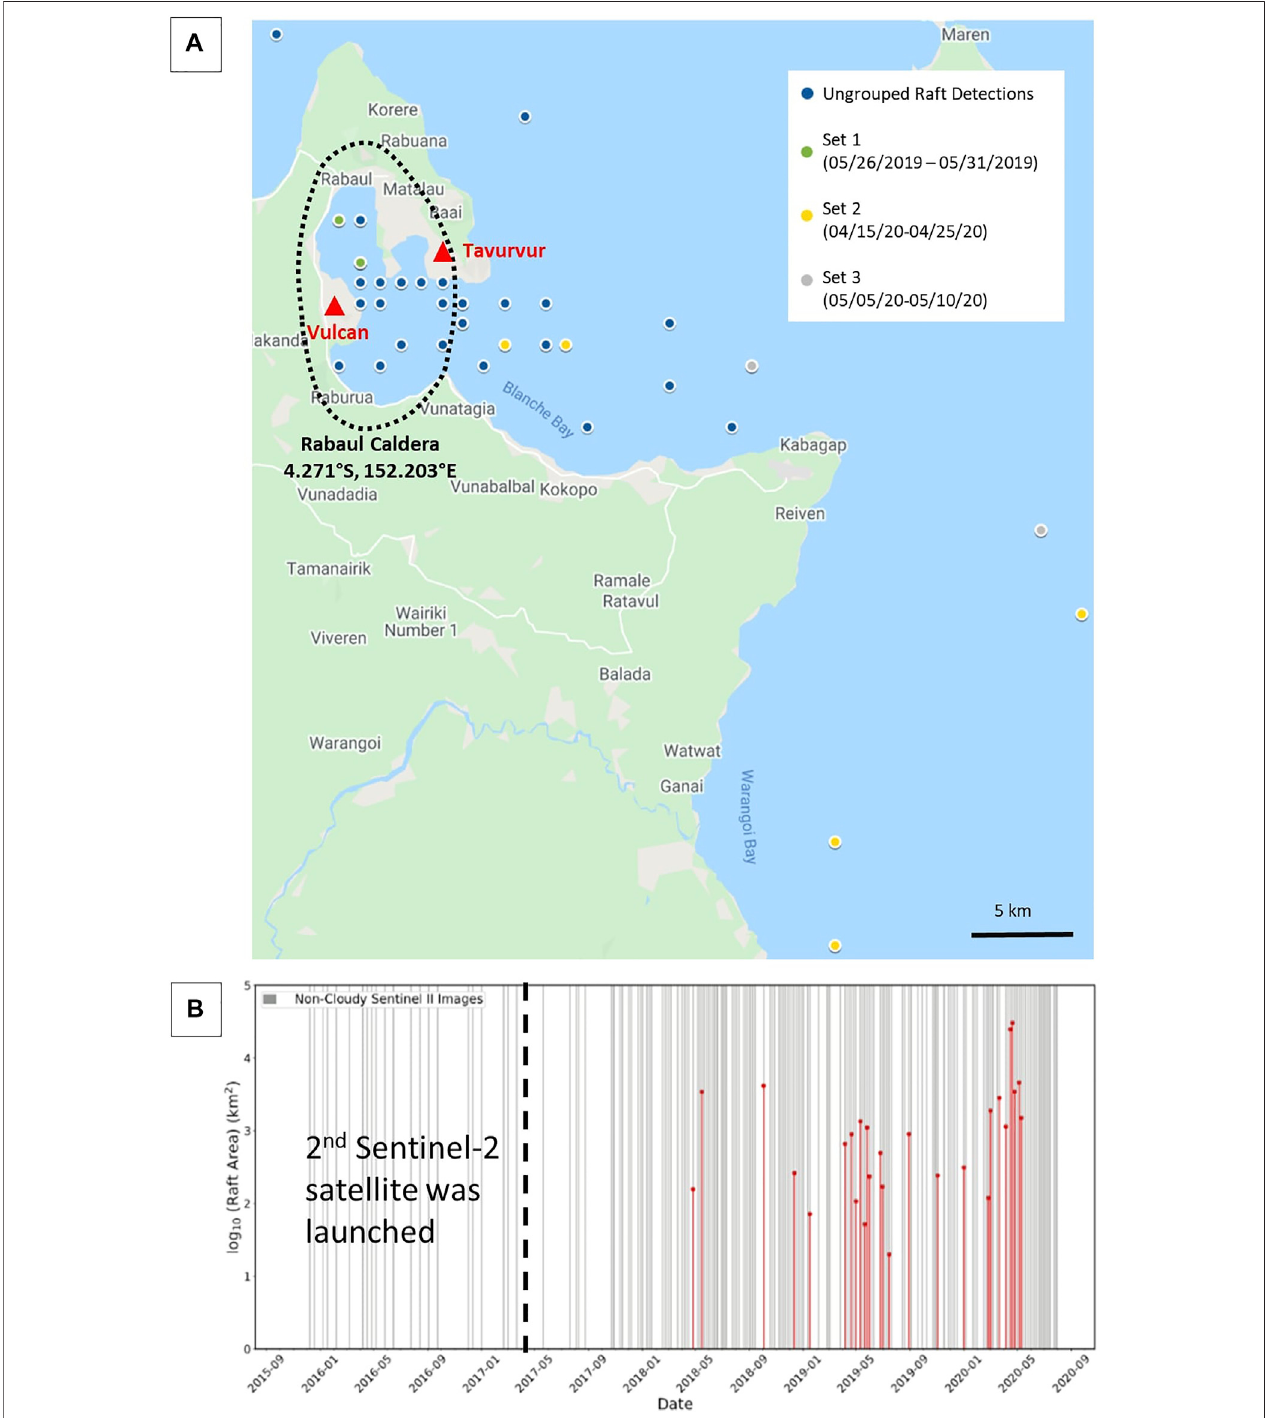
FIGURE 3| (A) Map of pumice raftdetection locations in Rabaul area. Main vent locations are marked with red triangles. Groupings ofraftdetections(by proximity in time and location) are indicated by the different colored icons (B) Non-cloudy days during Sentinel-2 coverage period, with raft detections in red (height indicating raft area).